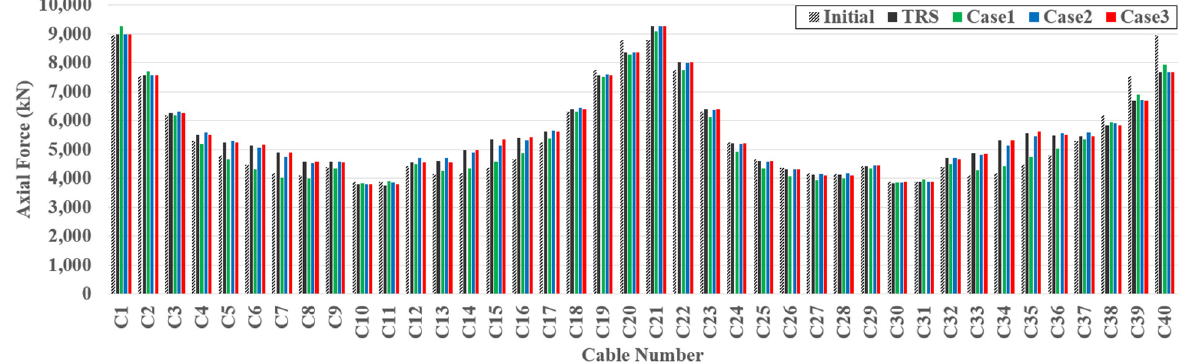
Figure 13. Example of estimated cable axial force for TM4.